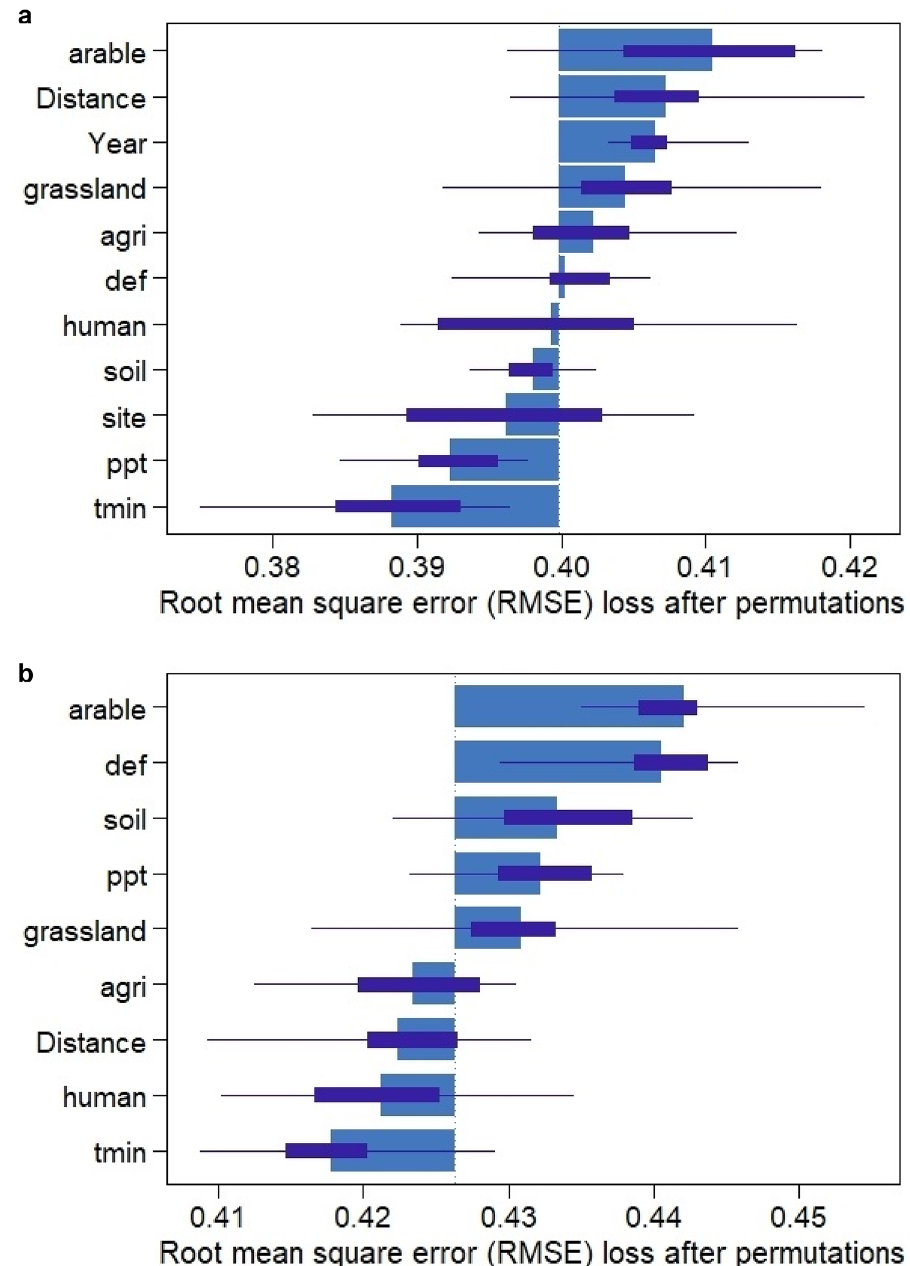
Figure 2. Importance of variables in models of nest occupation in years 2009–2018 (a) and 2016 (b) . Importance is expressed by loss-drop in RMSE. Dotted lines refer to loss-drop after perturbation of all predictors, i.e. the larger the bar, the higher the importance of a particular variable. Importance below dotted lines indicates variables with lower importance than random perturbation of all variables within a dataset. Abbreviations used in the table: arable—cover of non-irrigated arable lands, distance—ln distance to the nearest landfill, grassland—cover of pastures and meadows, agri—cover of other agricultural lands, def—average water deficit during breeding season, human—cover of highly human changed areas, soil moisture—average soil moisture at the end of each month during breeding season, site—site ID, ppt—average accumulated monthly precipitation during breeding season, tmin—average minimum temperature during breeding